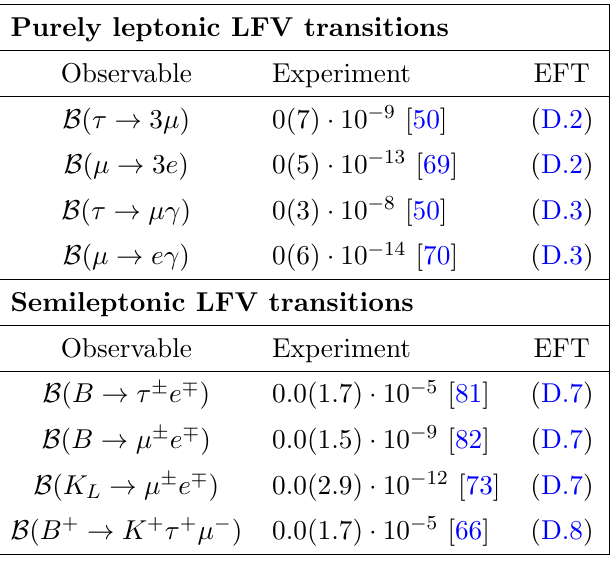
Table 7 . List of observables involving LFV